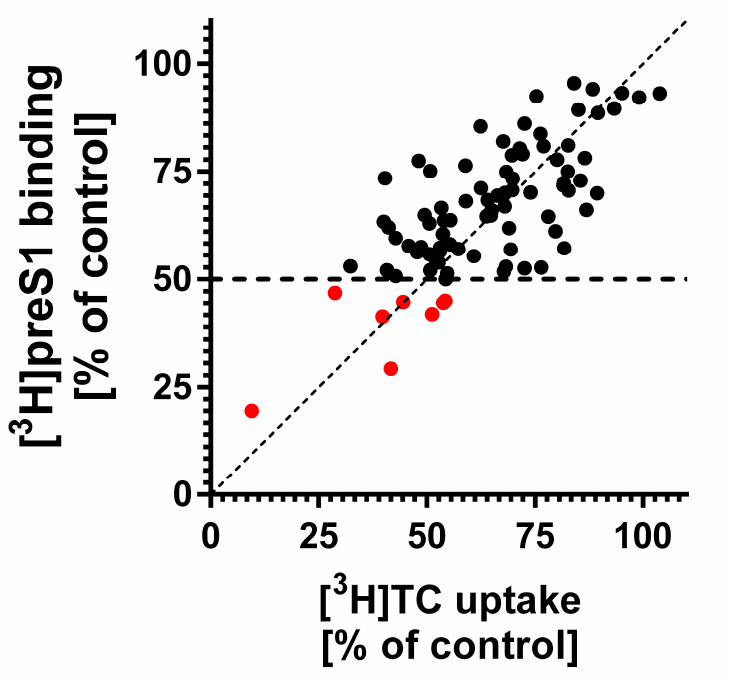
Figure 1. Inhibitory potency of 87 propanolamine derivatives on [ 3 H]TC uptake via NTCP and [ 3 H]preS1 lipopeptide binding to NTCP. NTCP-HEK293 cells were seeded onto 96-well plates and were incubated with tetracycline to induce expression of NTCP. Experiments were performed in the presence of 100 µ M inhibitor to block uptake of 1 µ M [ 3 H]TC (shown at the x -axis) and binding of 5 nM [ 3 H]preS1 (shown at the y -axis) over 10 min at 37 ◦ C. Control experiments were per- formed with solvent alone (set to 100%). Red dots represent the compounds S985852, A000028897, A000295480, S973515, A000289041, S973509, A000295231, and A000295013, which showed <50% remaining [ 3 H]preS1 binding compared to untreated control. Bisector is illustrated as dashed line. Compounds below the bisector line represent superior inhibitors of [ 3 H]preS1 lipopeptide binding compared to [ 3 H]TC uptake